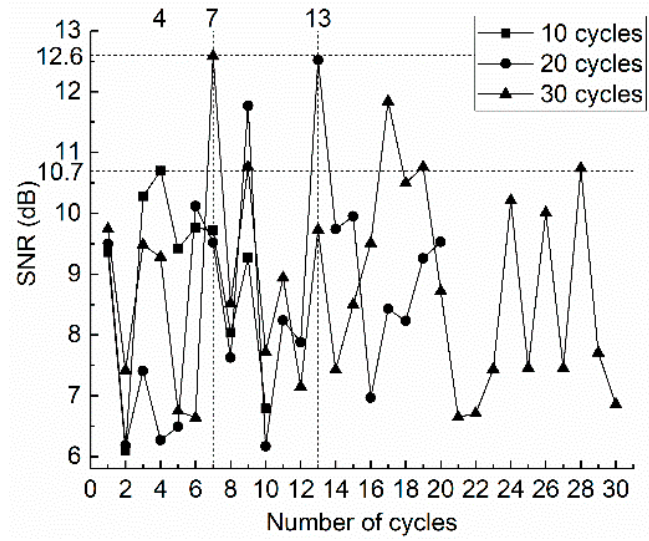
Figure 6. Comparison of the influence of cycle numbers on SNR.